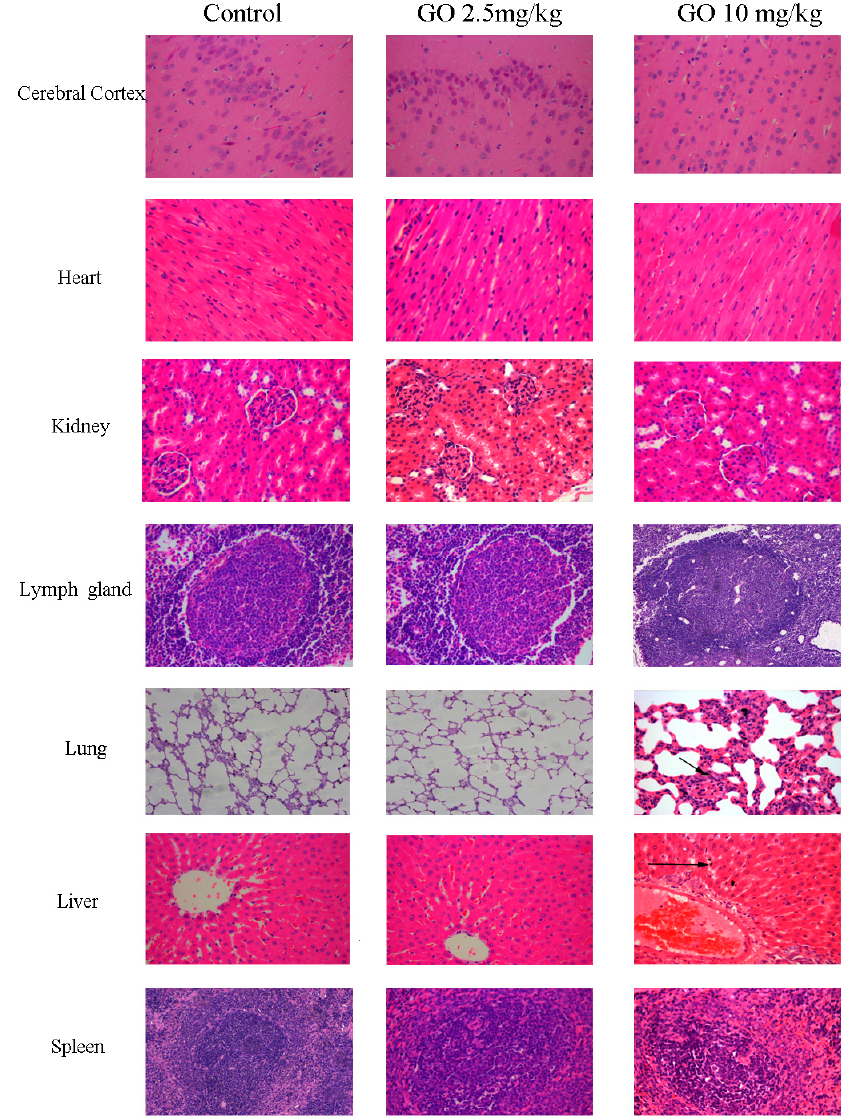
Figure 3. GO can induce an inflammatory response in lungs, liver, spleen. Rats treated with (2.5, 5, 10 mg/kg) did not undergo changes to the cerebral cortex, heart, kidney, and lymph glands, and there was no GO deposition in these organs. Only the highest dose of GO injured the liver, lungs, and spleen which were hyperemic and inflamed after seven days. Some GO aggregated in the lungs and liver. Black arrows indicate GO deposition.